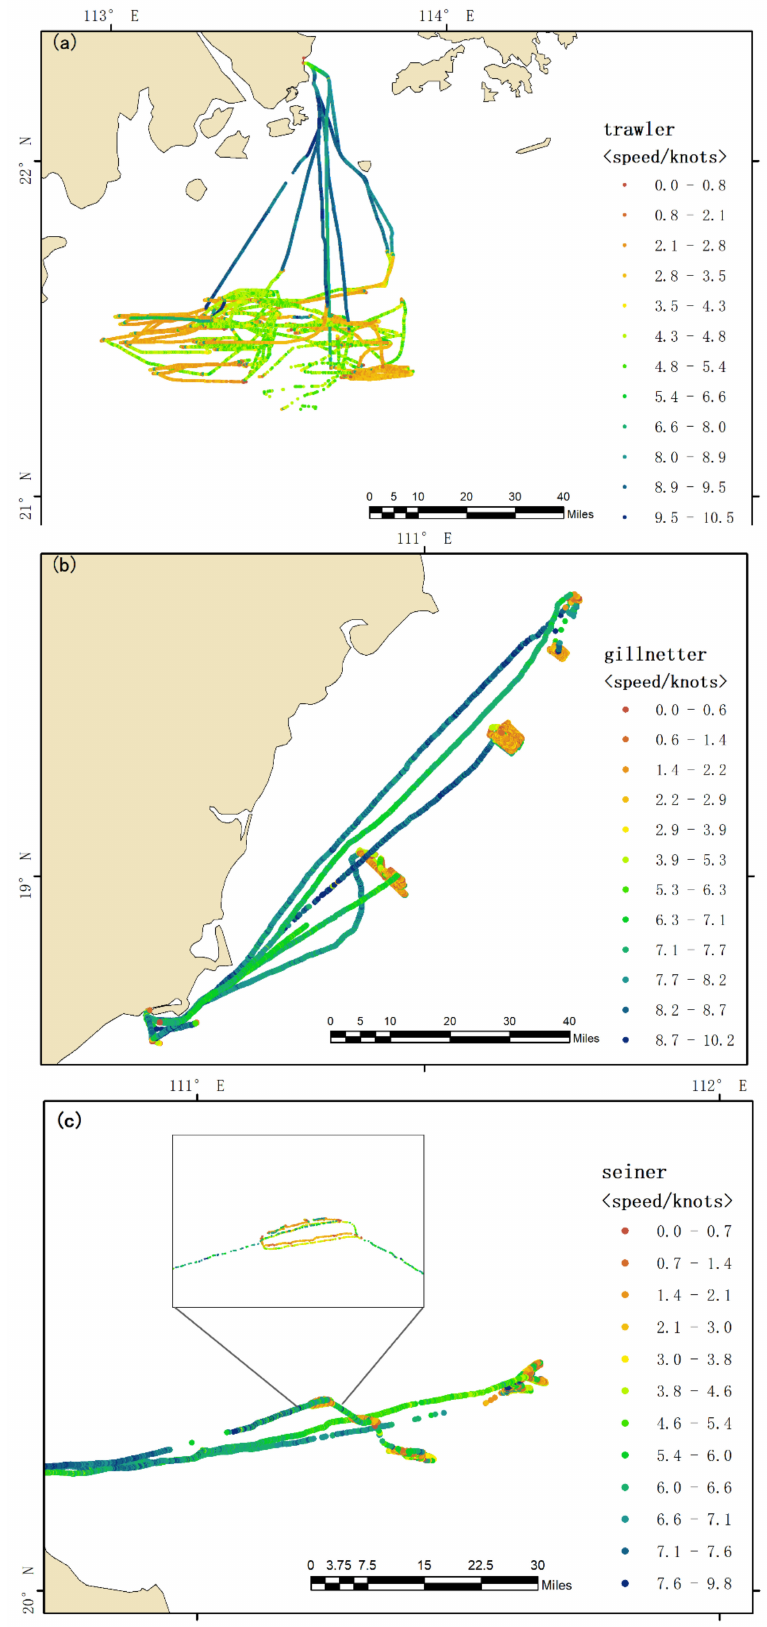
Figure 6. Fishing trajectory of a trawler ( a ), gillnetter ( b ) and seiner ( c ), where different colors are used to indicate speed